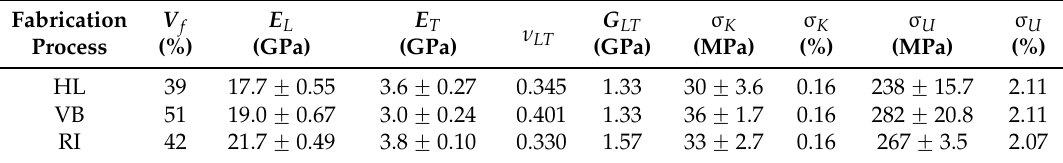
Table 2. Stiffness and strength measured parameters ( E Young’s modulus, G LT shear stiffness, σ K strain at knee yielding, σ U ultimate brittle failure stress, σ U strain at